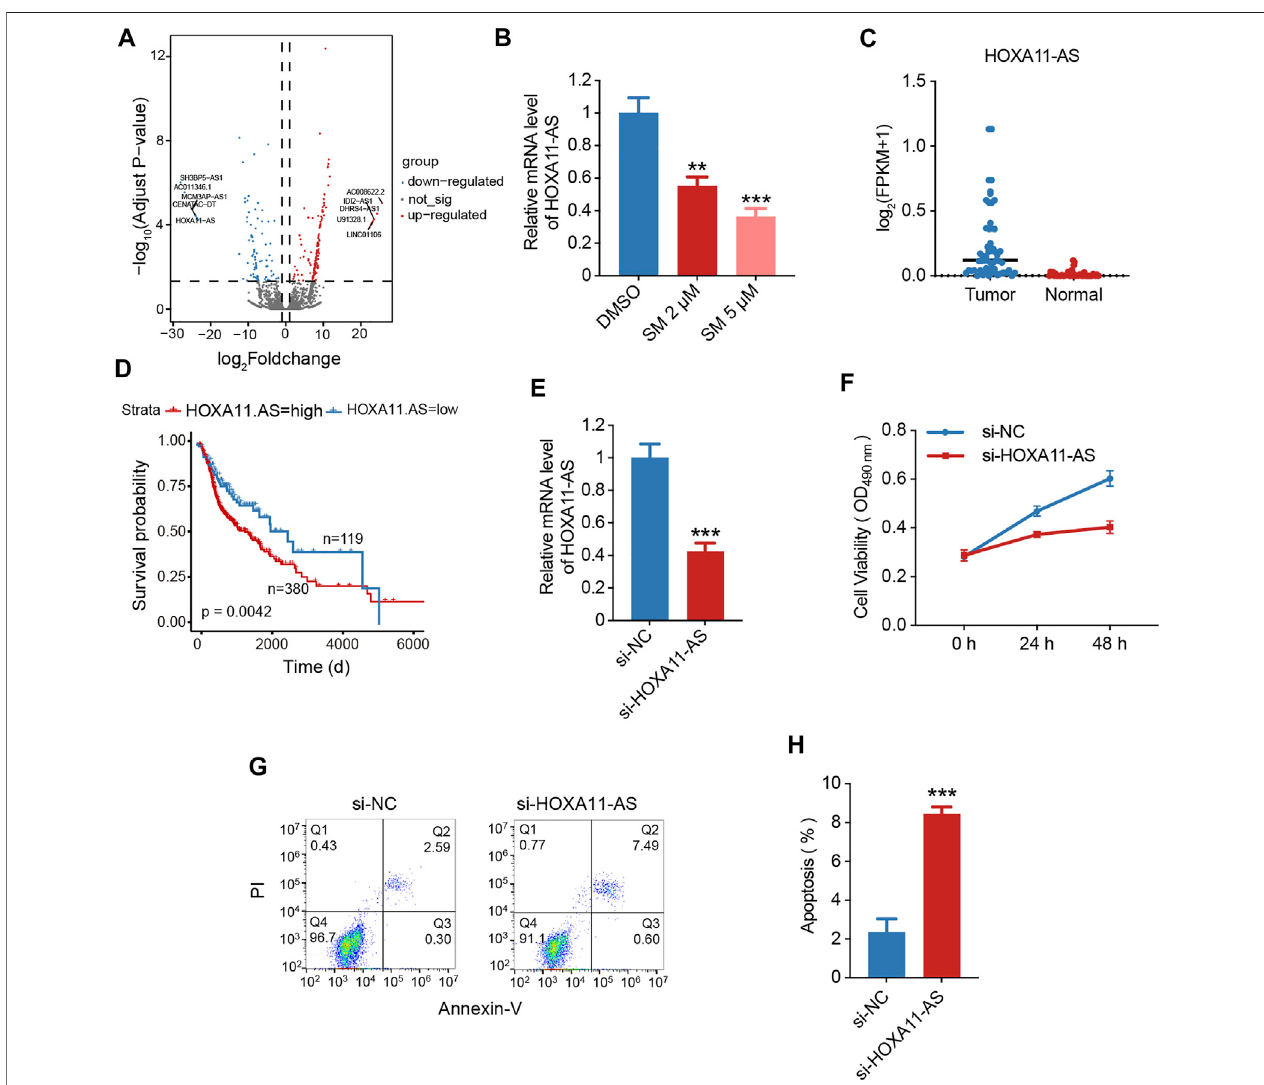
FIGURE 3 | SM suppresses the expression of lncRNA HOXA11-AS, which is responsible for the proliferation of FaDU cells. (A) Volcano plot shows differentially expressedlncRNAsinFaDUcellstreatedwithDMSOand5 μ MSM.BluedotsrepresentthedownregulatedlncRNAs,whilereddotsrepresenttheupregulatedones. (B) RelativeexpressionoflncRNA HOXA11-AS wasanalyzedbyRT-PCRafterDMSOand2and5 μ MSMtreatmentinFaDUcells. (C) Expressionof HOXA1-AS inheadand neck tumor tissue and in normal tissue. The cut-off value for low and high HOXA11-AS expression was 0.03143. (D) Impact of lncRNA HOXA11-AS expression levels on survival ofpatientswith hypopharyngeal cancer in TCGA database. (E) Relative expression oflncRNA HOXA11-AS in FaDU cells transfected with si-Nc and si- HOXA11-AS was detected by RT-PCR. (F) Cell viability of FaDU cells transfected with si-Nc and si-HOXA11-AS was analyzed by MTT assay at 0, 24, and 48 h ( n = 5). (G,H) Apoptosis of FaDU cells transfected with si-Nc and si-HOXA11-AS was analyzed by fl ow cytometry, and the total apoptotic percentage was calculated using FlowJo software. **( p < 0.01) and ***( p < 0.001) indicated statistically signi fi cant